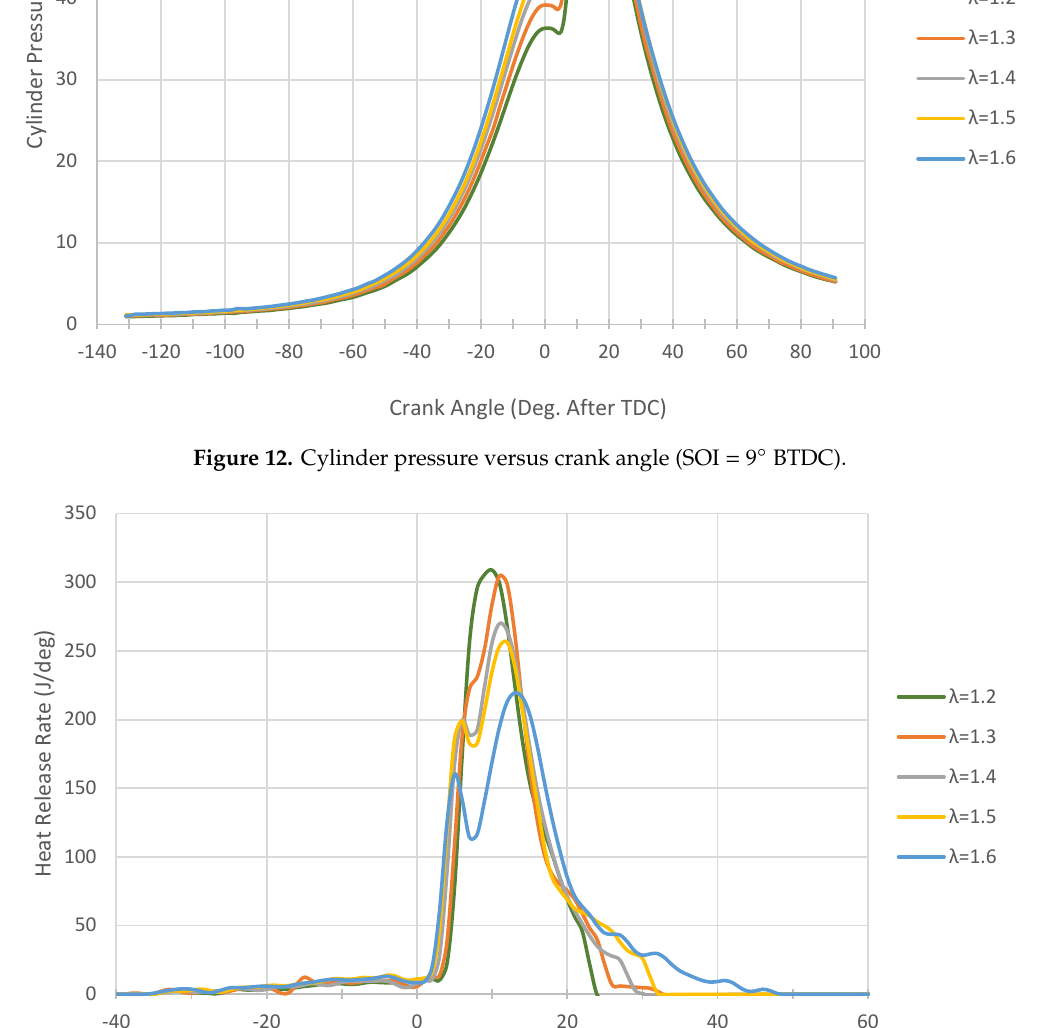
Table 7. Vibe coefficient m and combustion parameters.